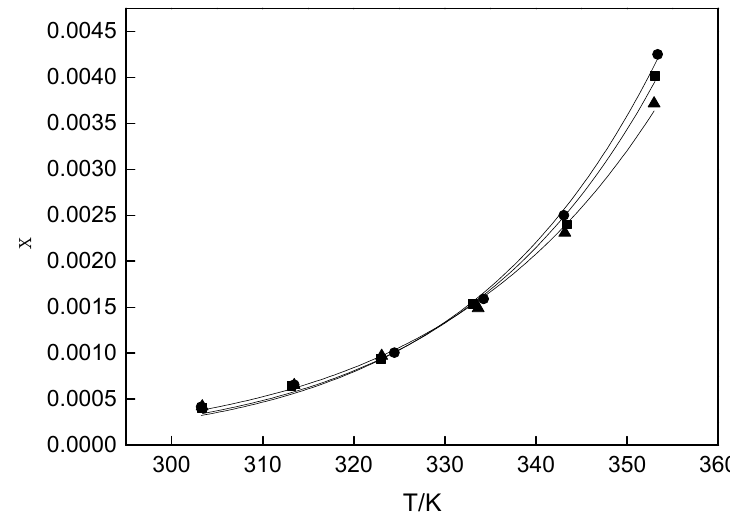
Figure 2. The solubility of β -Cyclodextrin in different solutions versus temperature with curve fitting using the Apelblat model. (cid:4) , 6% sucrose solution; (cid:8) , 8% NaCl solution; (cid:78) , mixture solution of 6% sucrose and 8% NaCl.